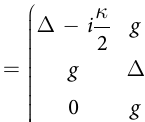
= 0.25 κ , κ = 0.75 κ and Δ = δ = 0 are ai ae